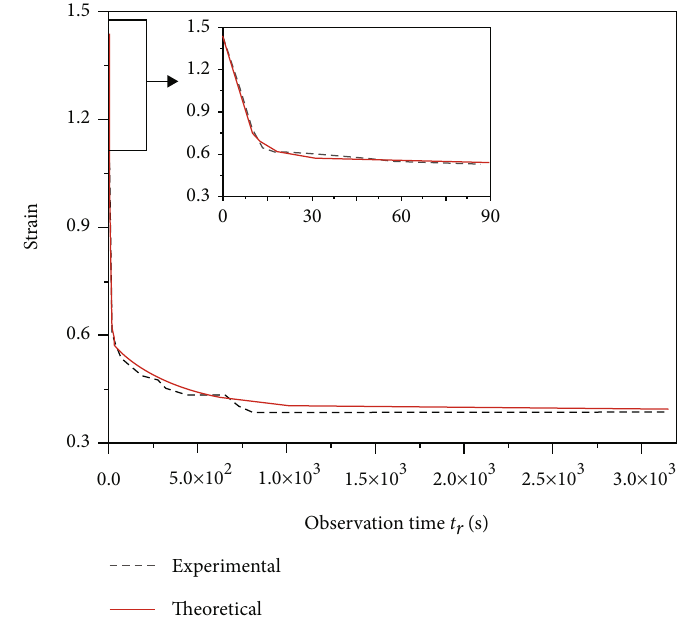
= 317 min . In inset: f